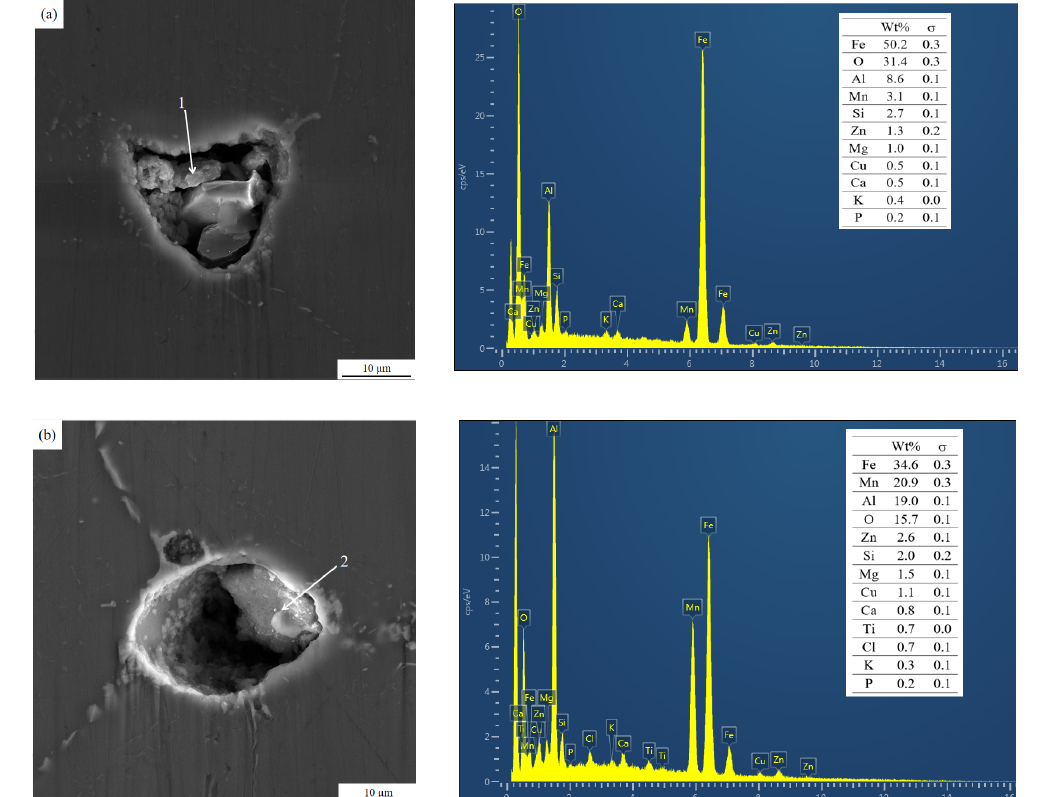
Figure 10. Inclusions contained in residual aluminum melt samples in ceramic cavity: inclusion morphology and EDS spectrum. ( a ) Inclusions 1/( b ) Inclusions 2.